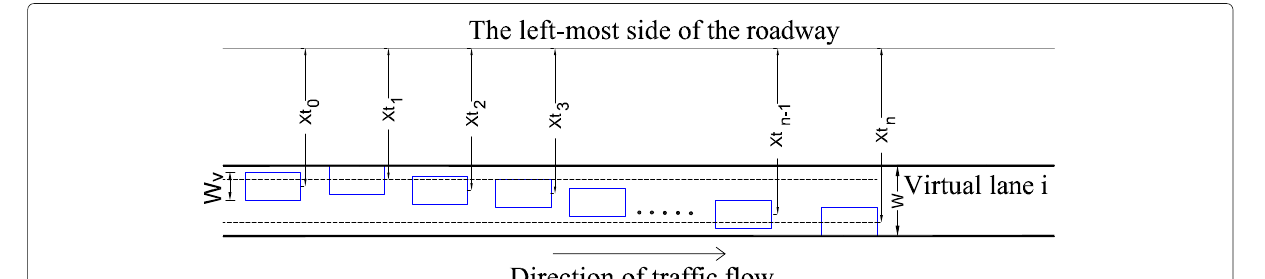
Fig. 2 Estimation of virtual lane width